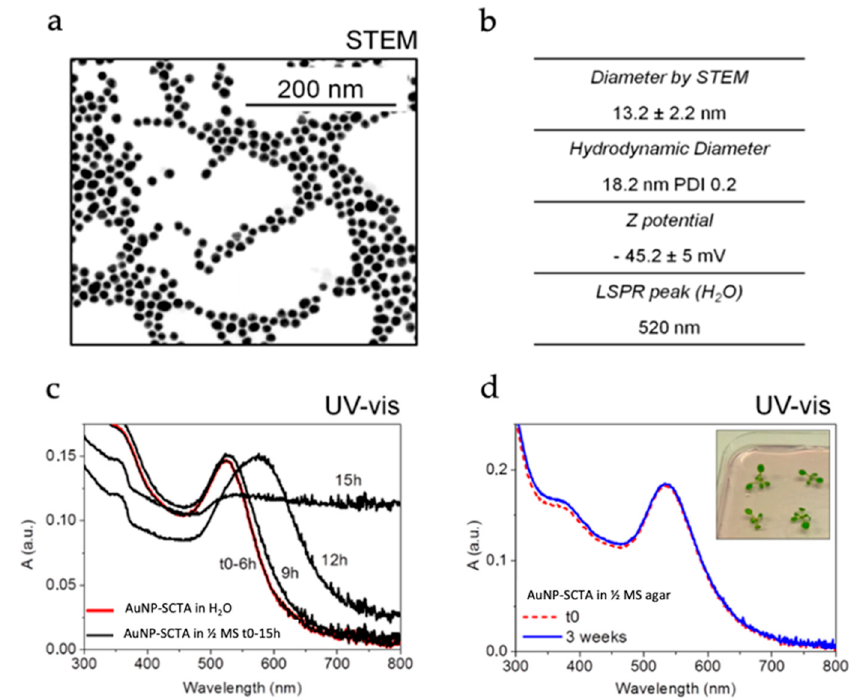
Figure 1. Physicochemical characterization of AuNP-SCTA dispersed in H 2 O, ½ MS, and ½ MS agar. ( a ) Bright field—scanning transmission electron microscopy (STEM) of AuNP-SCTA. ( b ) NP average diameter measured by STEM; hydrodynamic diameters (in H 2 O) measured by dynamic light scattering, reported as Z average and poly dispersity index (PDI); Z potential of the AuNP-SCTA dispersed in H 2 O (pH 6.5, conductivity 0.85 mS/cm). ( c ) UV-Vis spectra of AuNP-SCTA dispersed in H 2 O (red) and over time (from time 0 to 15 h) in ½ MS (black). ( d ) UV-Vis spectra of AuNP-SCTA dispersed in ½ MS agar at time 0 (red dashed) and after 3 weeks of exposure (blue); representative photograph of Arabidopsis seedlings germinated and grown for 1 week on an agar plate containing ½ MS and AuNPs, showing a typical reddish color of non-aggregated AuNPs-SCTA. Absorbance A in arbitrary units (a.u.). All experiments were repeated twice with similar results.